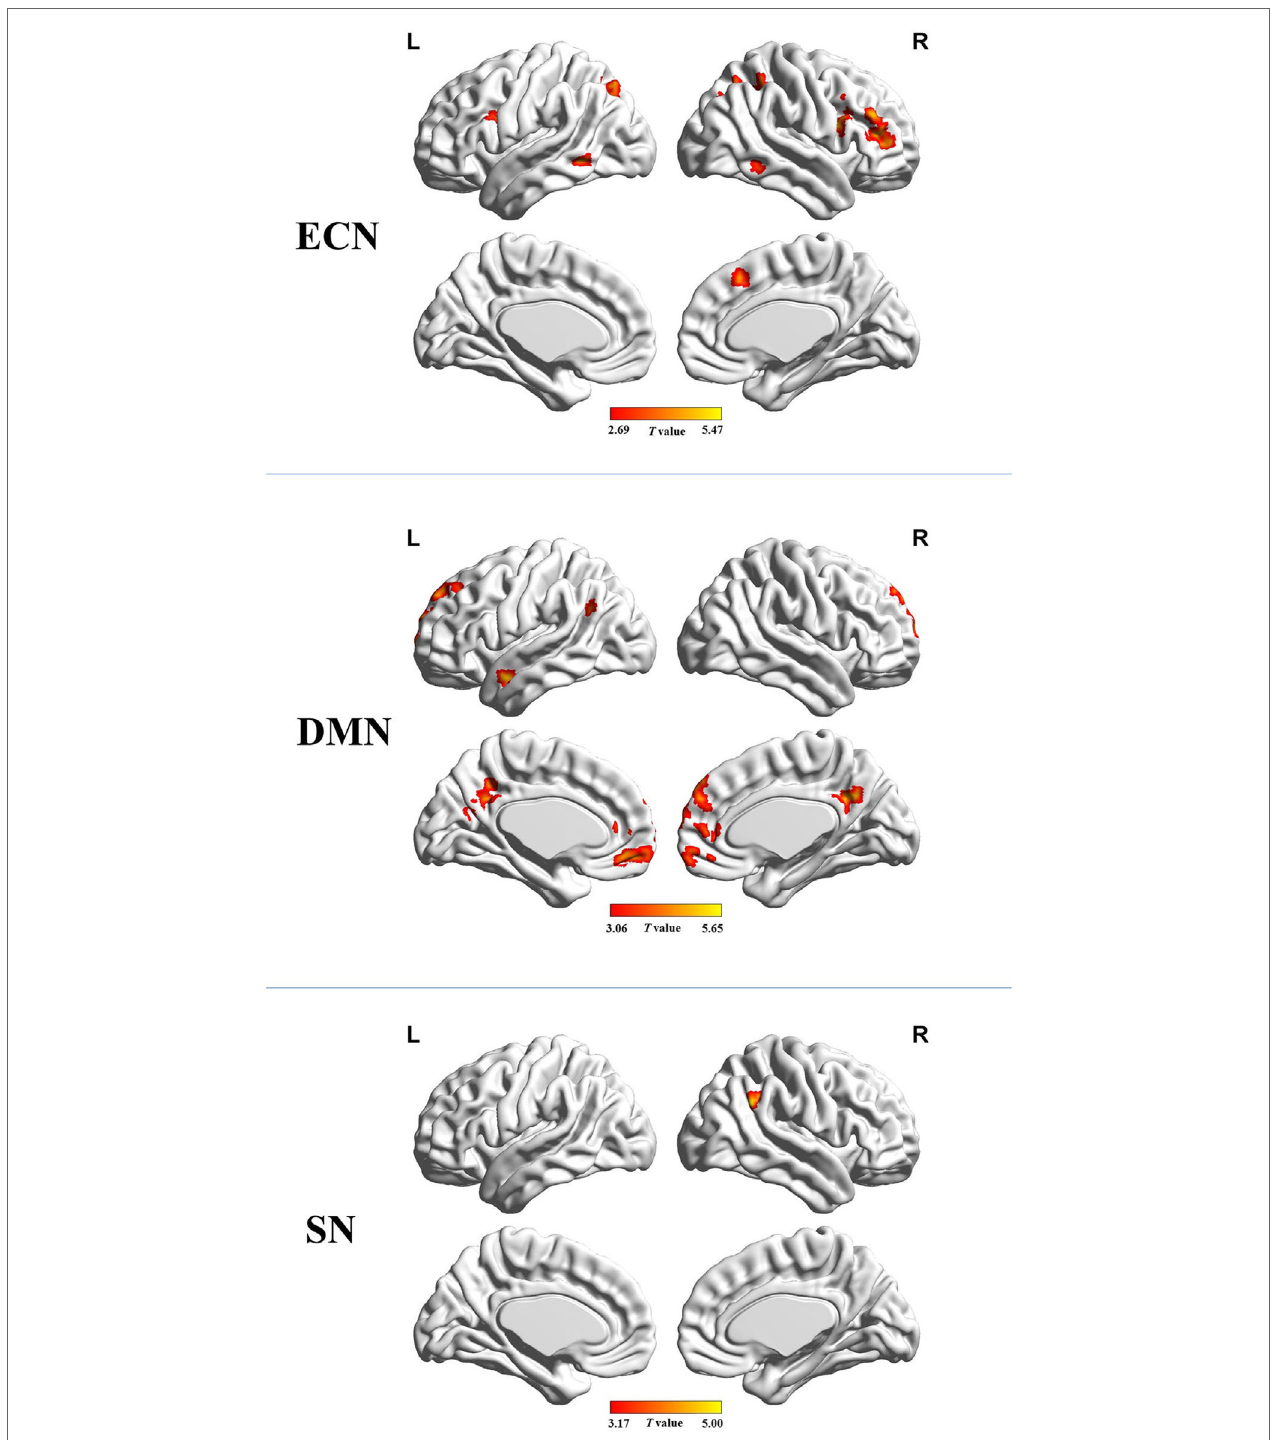
FigUre 3 | Brain regions in which functional connectivity with the network seed was significantly reduced in the cirrhotic patients. Abbreviations: ECN, executive control network; DMN, default mode network; SN, salience network. A threshold of P < 0.05 (false discovery rate corrected) was set to identify significance level.